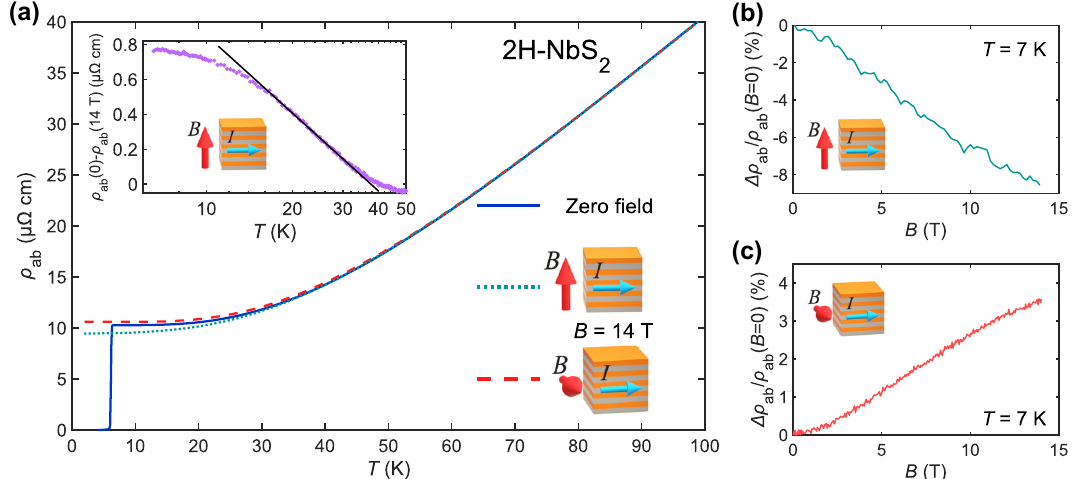
Fig. 4 In-plane magnetotransport in 2H-NbS 2 . a In-plane resistivity ( ρ ab ) as a function of temperature ( T ) at zero and 14 T magnetic fi eld ( B ). The change of ρ ab between zero fi eld and 14 T (out-of-plane fi eld) is plotted in the inset on a logarithmic T scale. The black line in the inset corresponds to the logarithmic temperature dependence. b , c In-plane magnetoresistance for the out-of-plane ( b ) and in-plane ( c ) fi